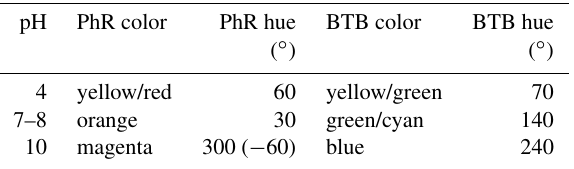
Table 1. Estimated color angles of BTB (bromothymol blue) and PhR (phenol red) in different pH values based on the HSV color space model with hue values in brackets indicating the correspond- ing negative hue